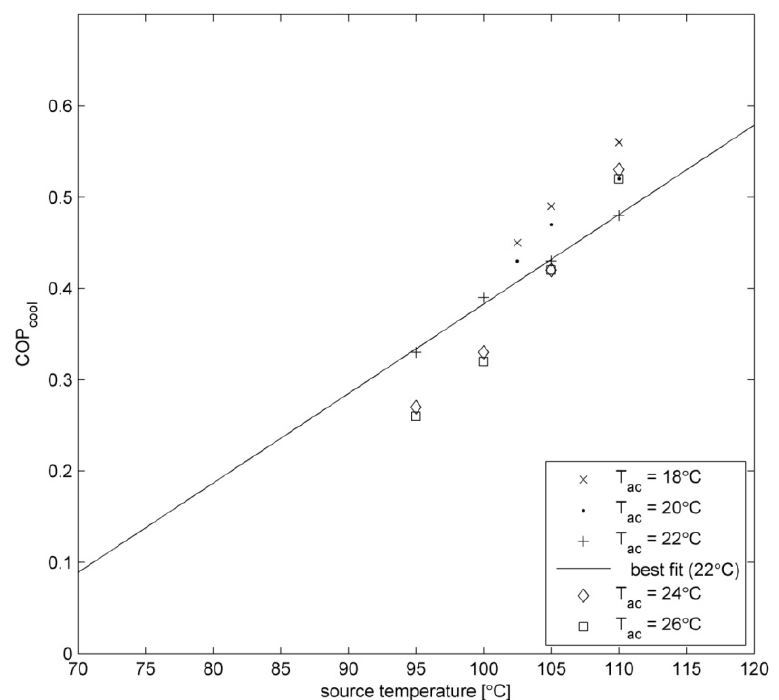
Figure 9. COP against heat source for 30 °C heat sink